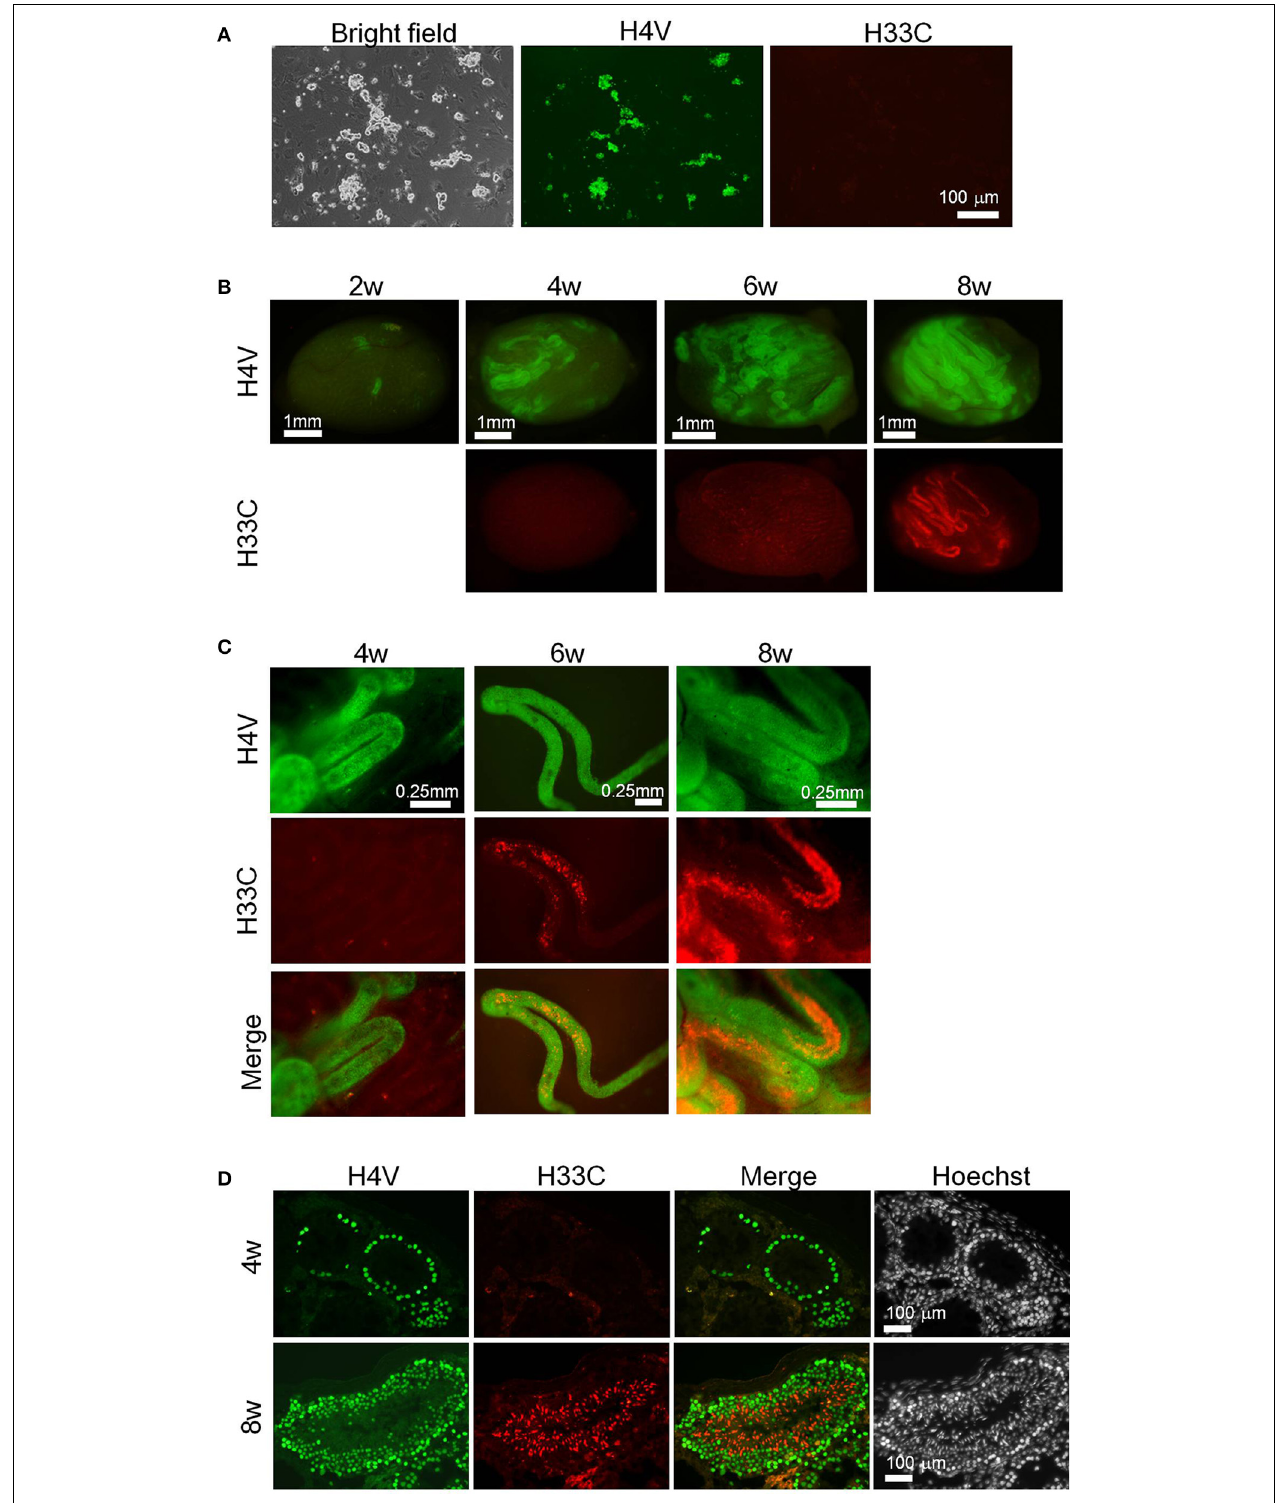
FIGURE 5 | Transplantation assay using H4V/H33C double Tg SSCs. (A) Isolation of SSCs ( = donor cells) from H4V/H33C double Tg mice. (B) Gross view of the recipient testes representing efficiency of the engraftment after transplantation. The examined